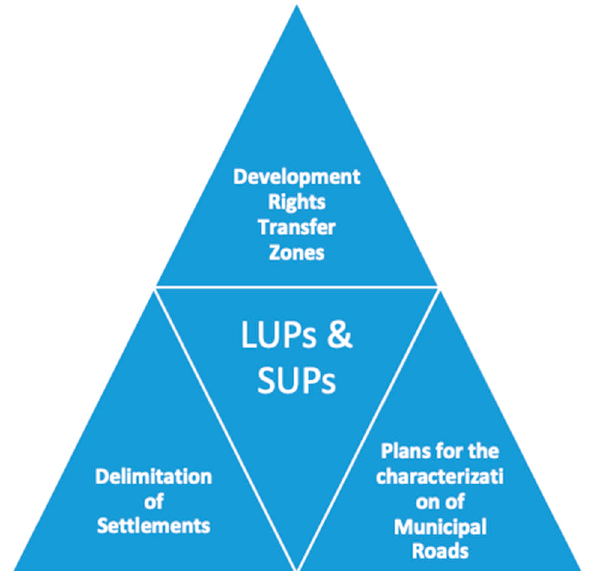
Figure 6. The Local Urban Plans (LUPs) and the Special Urban Plans (SUPs) consist of five (5) ac- tions.